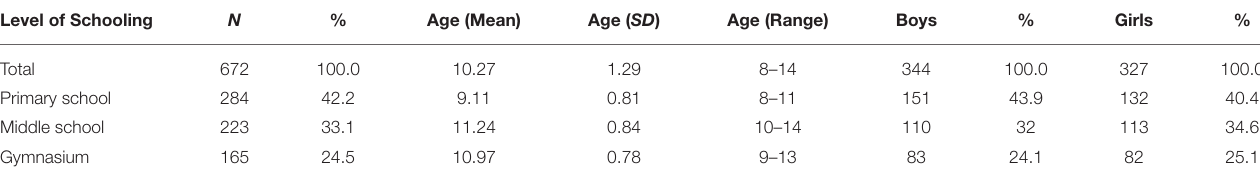
TABLE 1 | Amount of children by level of